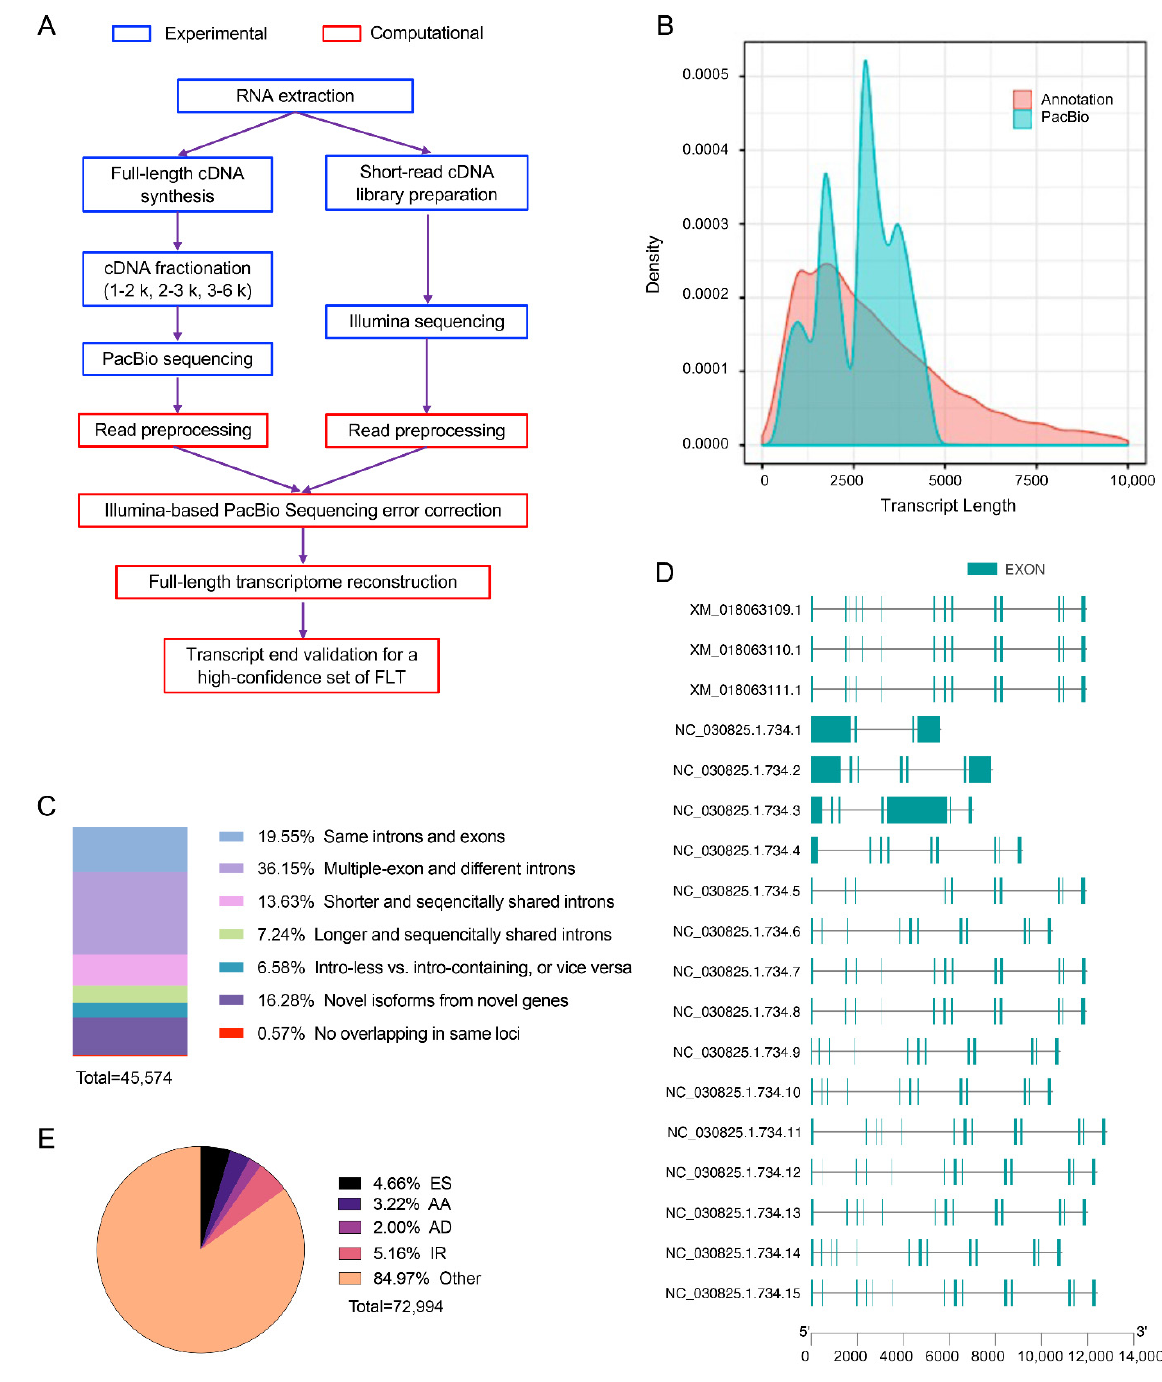
Figure 1. Full-length transcriptomic sequencing improves the understanding for goat transcriptome. ( A ) Hybrid sequencing strategy used in this study. PacBio third generation and Illumina second generation sequencing were used to obtain the full-length and expression level of transcript, respectively. ( B ) Comparison between goat RefSeq from NCBI and PacBio data obtained from this study. ( C ) Classification of full-length transcripts obtained from third generation sequencing. ( D ) Known transcripts (XM_*) of TNNT1 already annotated by NCBI and newly discovered transcripts (NC_*) in this study. ( E ) Types of alternative splicing identified from full-length sequencing. ES, exon skipping; AA, alternative acceptor; AD, alternative donor; IR, intron retention.